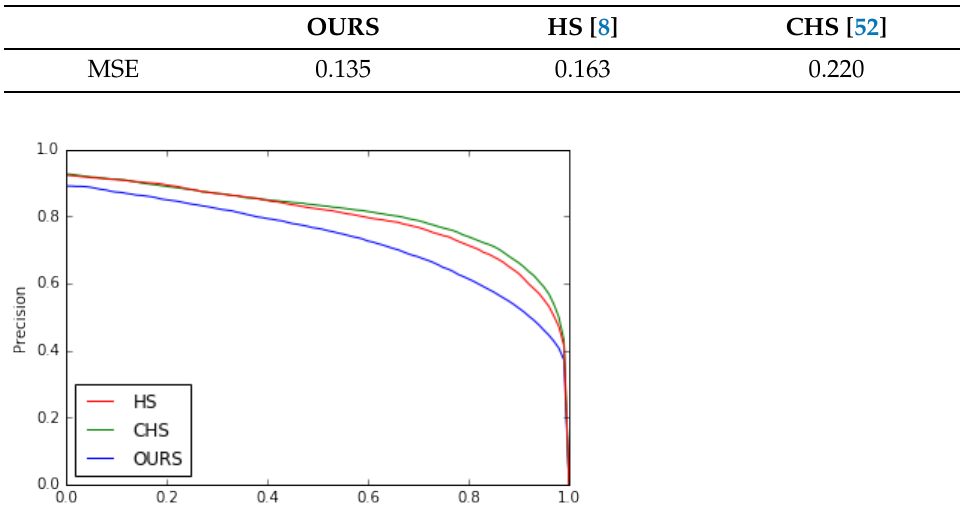
Table 5. Our model’s MSE measure results compared with two state-of-the-art HS [8] and CHS [52] models for the ECSSD dataset (for MSE, the smaller value is the best).